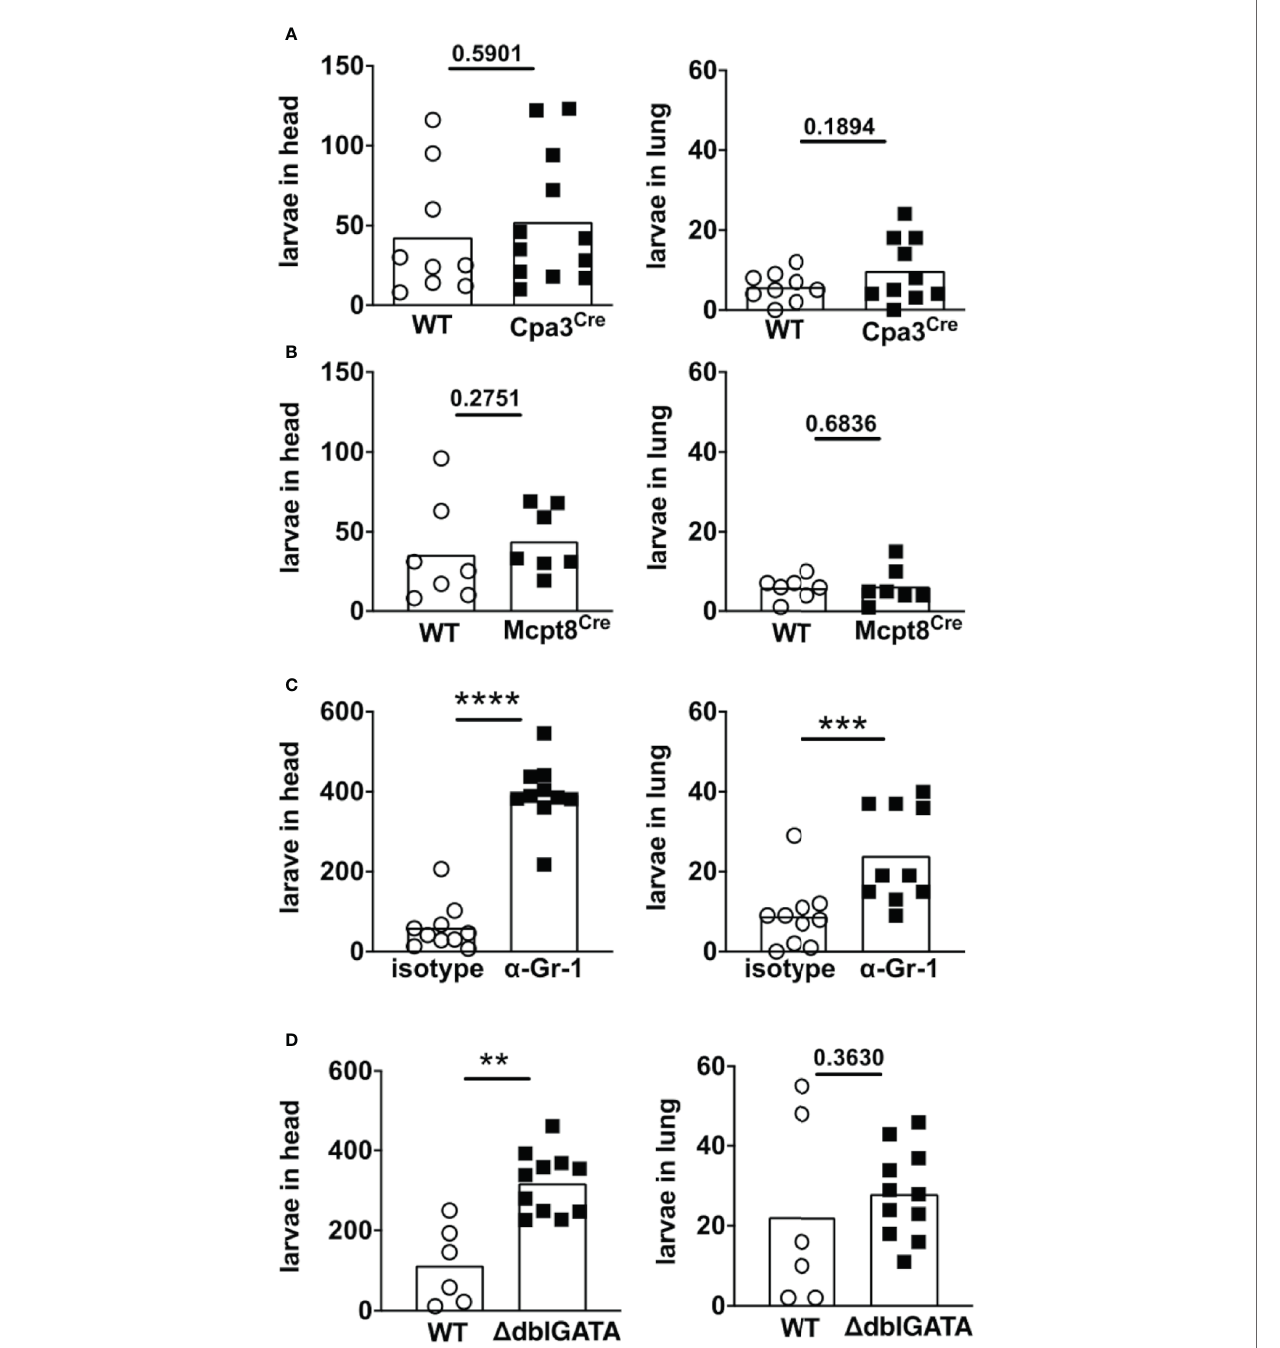
FIGURE 2 | Eosinophils and neutrophils mediate killing of S. ratti L3 in the tissue during 1 st infection. Mice were infected with 2000 S. ratti L3 by s.c. injection into the footpad and sacri fi ced 2 days later. S. ratti L3 that emigrated out of the head and lung tissue were counted. Used were (A) mast cell-de fi cient mice Cpa3 Cre mice (black squares) or their Cpa3 WT littermates (open circles) or (B) basophil-de fi cient Mcpt8 Cre mice (black squares) and Mcpt8 WT littermates (open circles) or (C) Gr-1 + cell-depleted mice (black squares) or isotype-treated (open circles) BALB/c mice or (D) eosinophil-de fi cient D dblGATA mice (black squares) and BALB/c WT mice (open circles). Graphs show combined results derived out of 2 independent experiments with 3 - 6 mice per group and experiment, each symbol represents an individual mouse, bars indicate the mean and asterisks signi fi cant differences of the mean (students t-test, p < 0.01 **; p < 0.001 ***; p < 0.0001 ****). Gr-1 + depletion was controlled day one p.i. and depletion is shown in Supplementary Figure S1 . Eosinophil and neutrophil accumulation in the skin was seen already after 3 h and 6 h post infection and is shown in Supplementary Figure S4